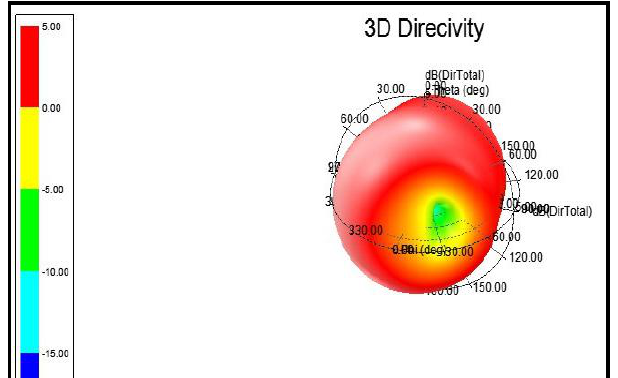
Figure 10: Polar radiation pattern of antenna at 2GHz.